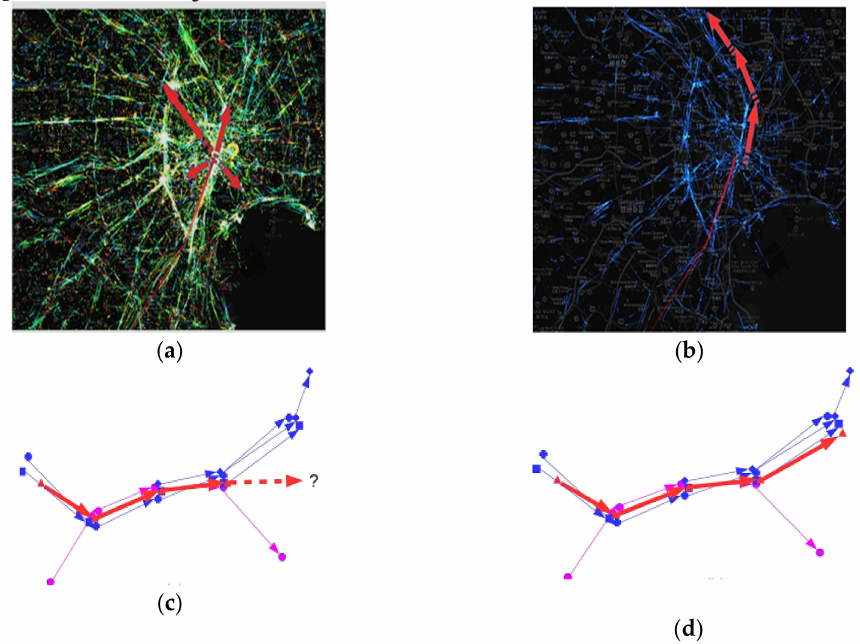
Figure 7. ( a , c ) Partitioning subjects’ movement into clusters; ( b , d ) Prediction of future movements based on the best-matching cluster